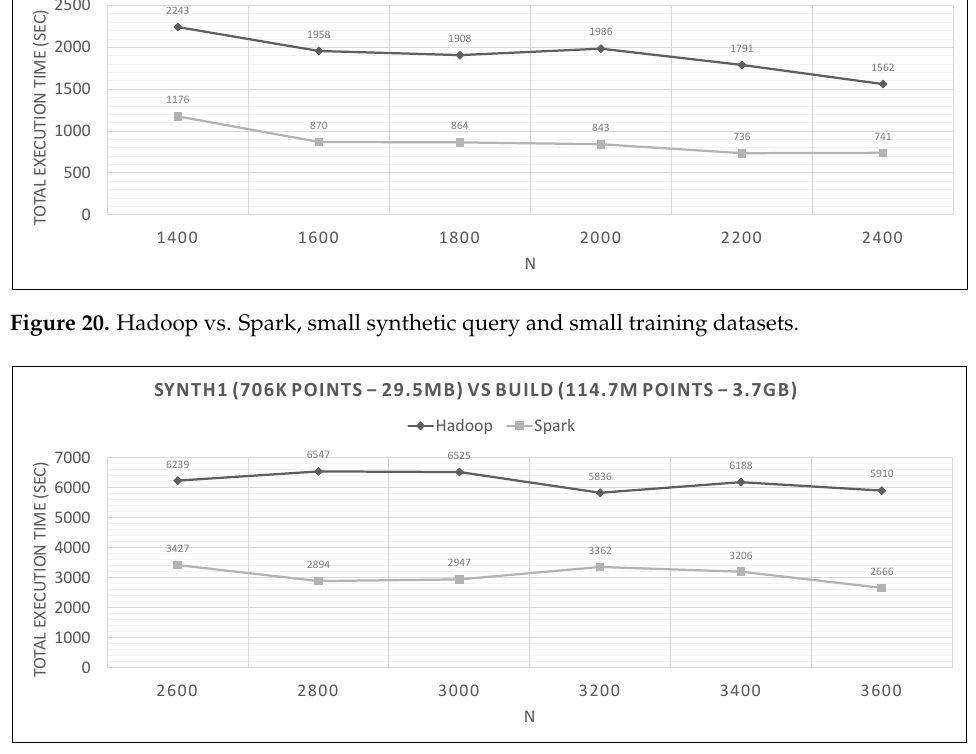
Figure 21. Hadoop vs. Spark, small synthetic query and medium training datasets.